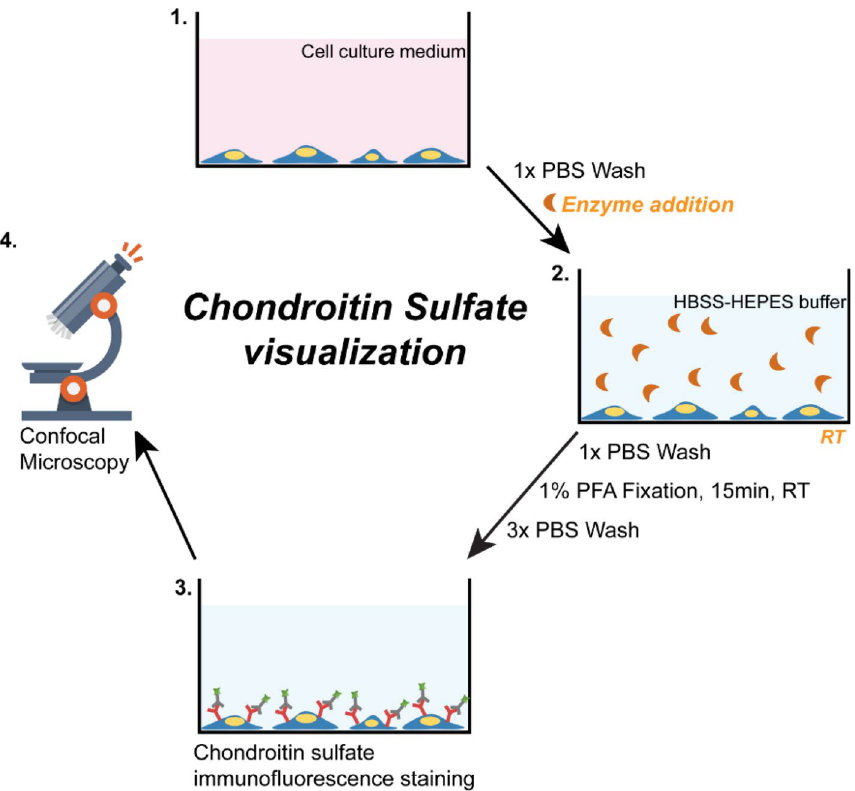
Figure 2. Chondroitin sulfate immunostaining. Cartoon explaining point-by-point the steps of the culture and staining procedure leading to the visualization of surface chondroitin sulfate. After 2–3 days of culture cells were washed with PBS and treated with ChrABC enzyme. After the end of the incubation time cells were washed with PBS, fixed with paraformaldehyde (PFA)-PBS and immunohistochemistry was performed and visualized by confocal